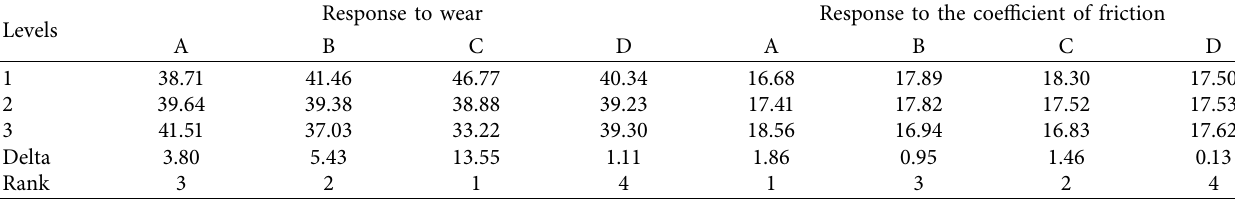
Table 8: Response table for S/N ratios: smaller is